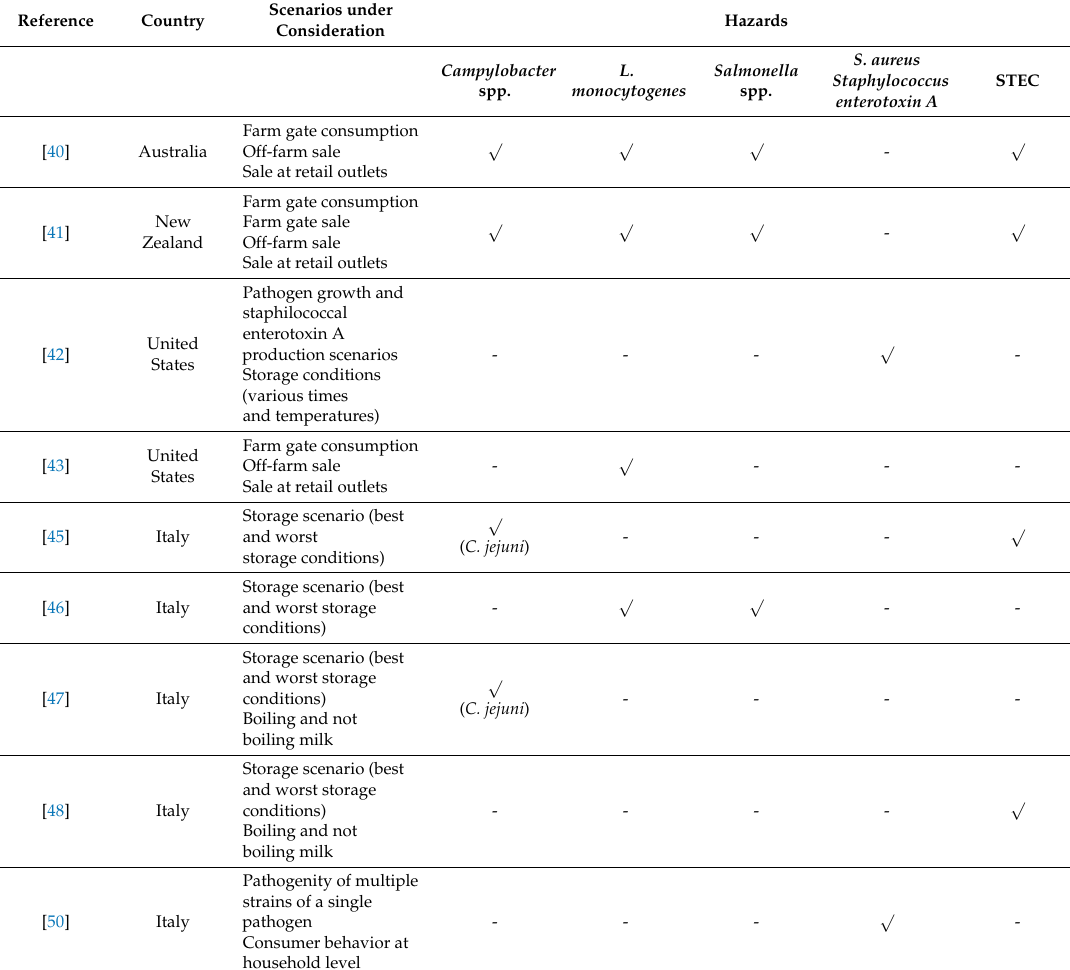
Table 3. Microbiological hazards upon raw milk consumption analyzed in the currently available QMRA